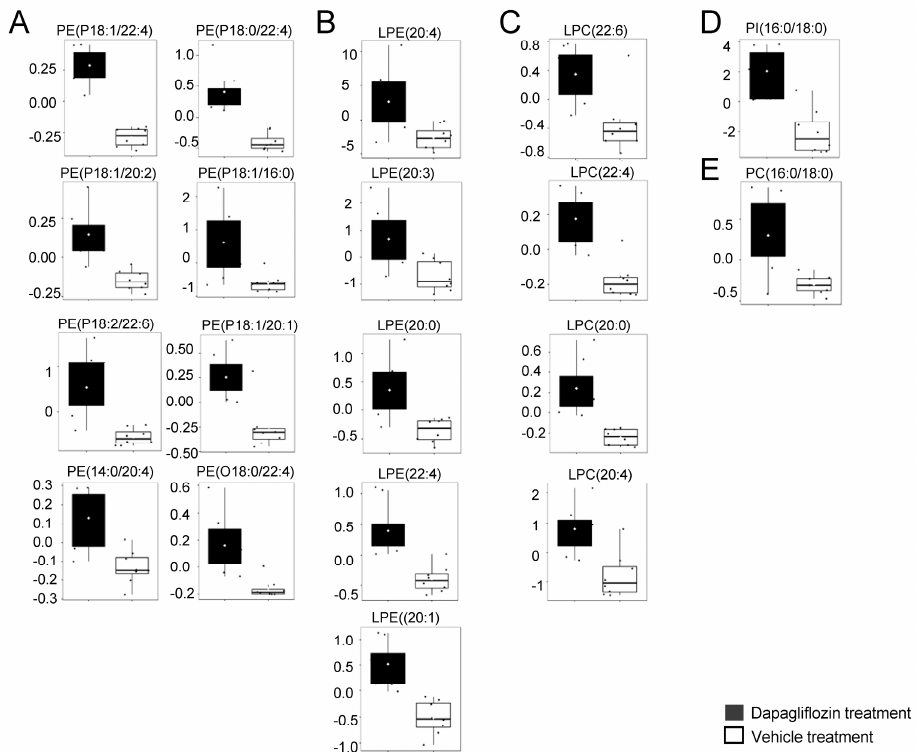
Figure 3. Lipids significantly upregulated in the kidneys of dapagliflozin-treated salt-loaded hy- pertensive diabetic db/db mice compared to the vehicle-treated db/db mice. ( A ) Plots of PEPs, PEOs, and PEs, ( B ) plots of lysophosphatidylethanolamines (LPEs), ( C ) plots of lysophosphatidylcholines (LPCs), ( D ) plots of phosphatidylinositols (PIs), and ( E ) plots of phosphatidylcholines (PCs). The concentration of each lipid is given in µmol/g. The concentration of each lipid was normalized to the median. The black (left bar) represents the dapagliflozin group, and the white (right bar) represents the vehicle group.